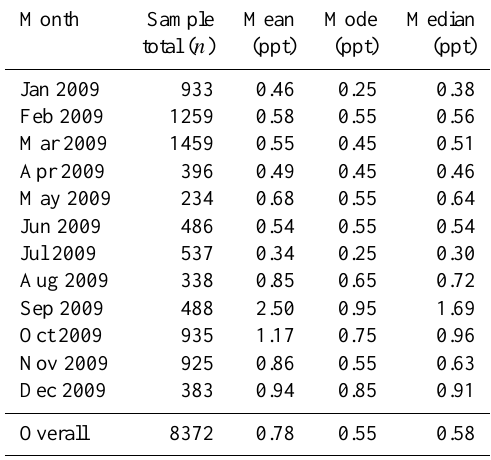
Table 3d. Statistical summary for CH 3 I at Tawau only.